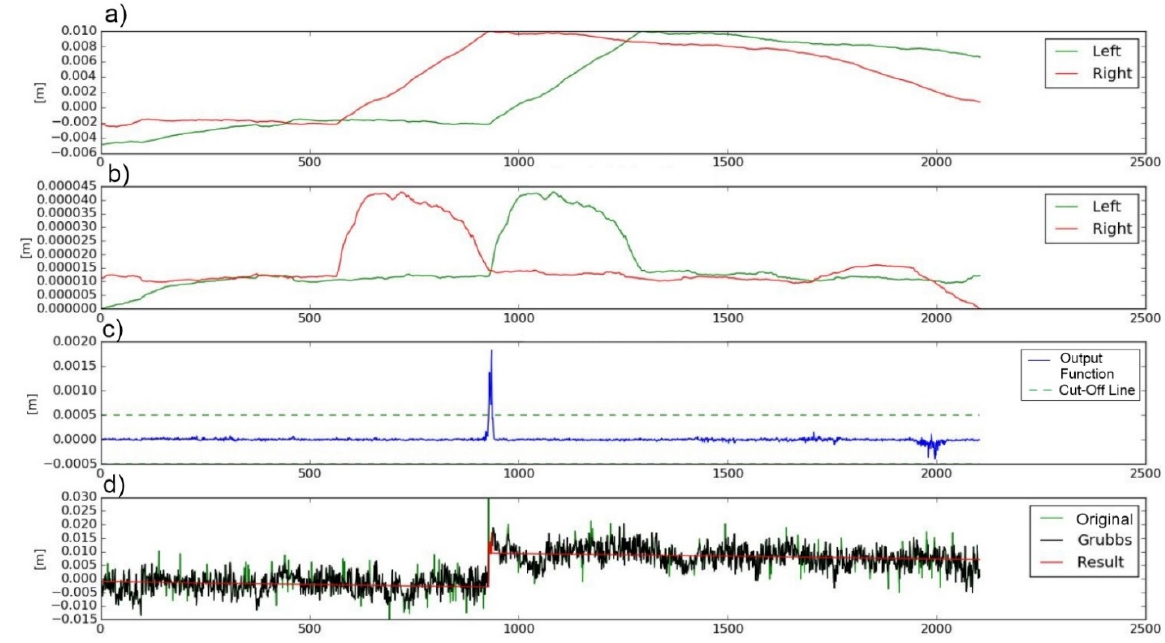
Figure 7. Steps of the VSED algorithm (KONE station): ( a ) Left and right moving averages are calculated according to Equation (2) from [32]; ( b ) Left and right standard deviations are the square root of Equation (3) from [32]; ( c ) The output function is Equation (4) from [32]; ( d ) The result of detection. The units on the y-axis are in metres. The units on the x-axis are the number of observations.